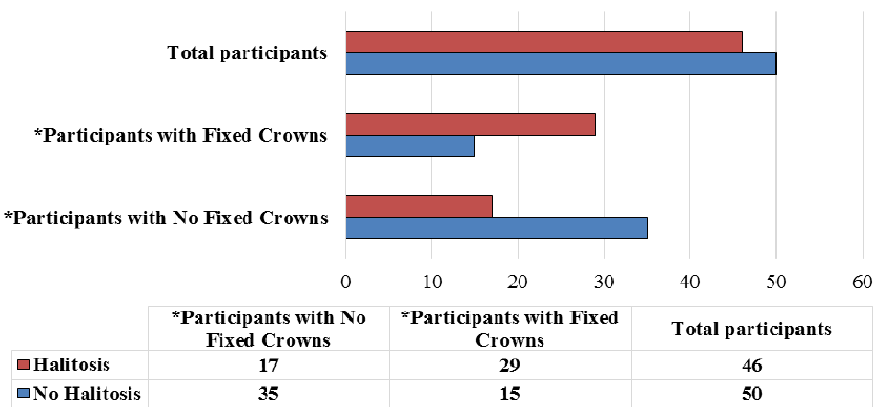
Analysis of breath samples from 96 participants revealed detectable levels of VSCs to the level of halitosis in 46 (47.9%) of the total subjects (Figure 1). Halitosis was more prevalent among participants with fixed crowns as compared to control group. Statistically significant correlations were observed between the presence of fixed crowns and oral halitosis ( p < 0.001) (Figure 1).